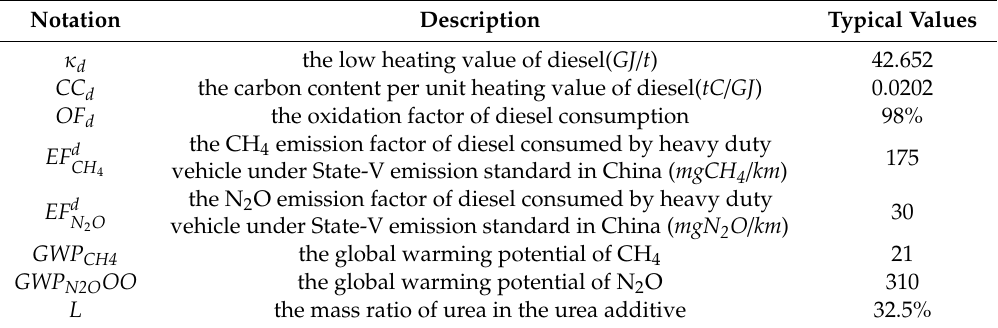
Table 5. Relevant parameters of GHG emissions calculation model for MSW